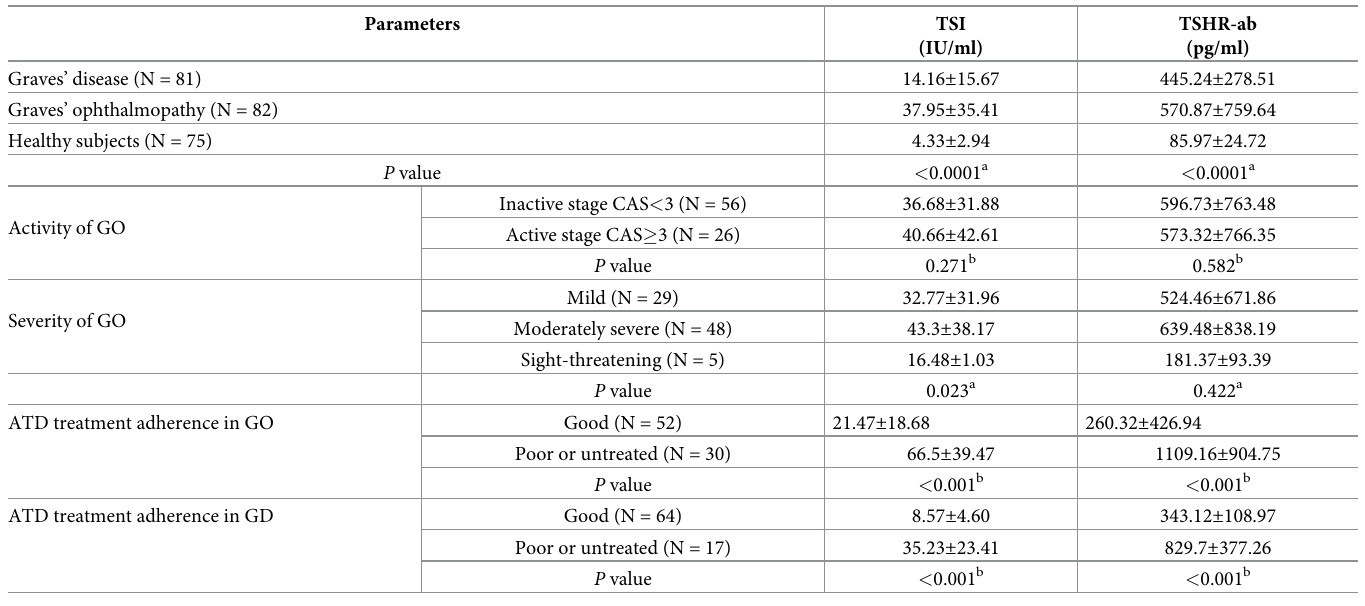
Table 2. The TSI and TSHR-ab levels in GD and